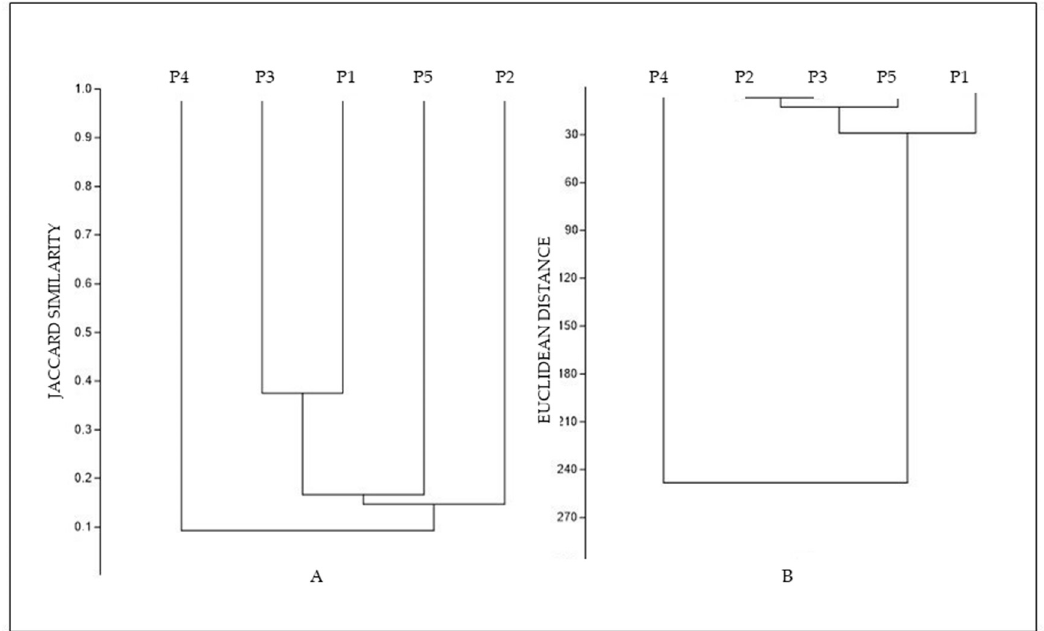
Figure 2. Grouping dendrograms for sampling plots. ( A ) Qualitative grouping dendrogram obtained with the Jaccard’s Similarity index; ( B ) Quantitative grouping dendrogram obtained with Euclidean distances. P1, P2, P3; P4, P5 are sampling plots.